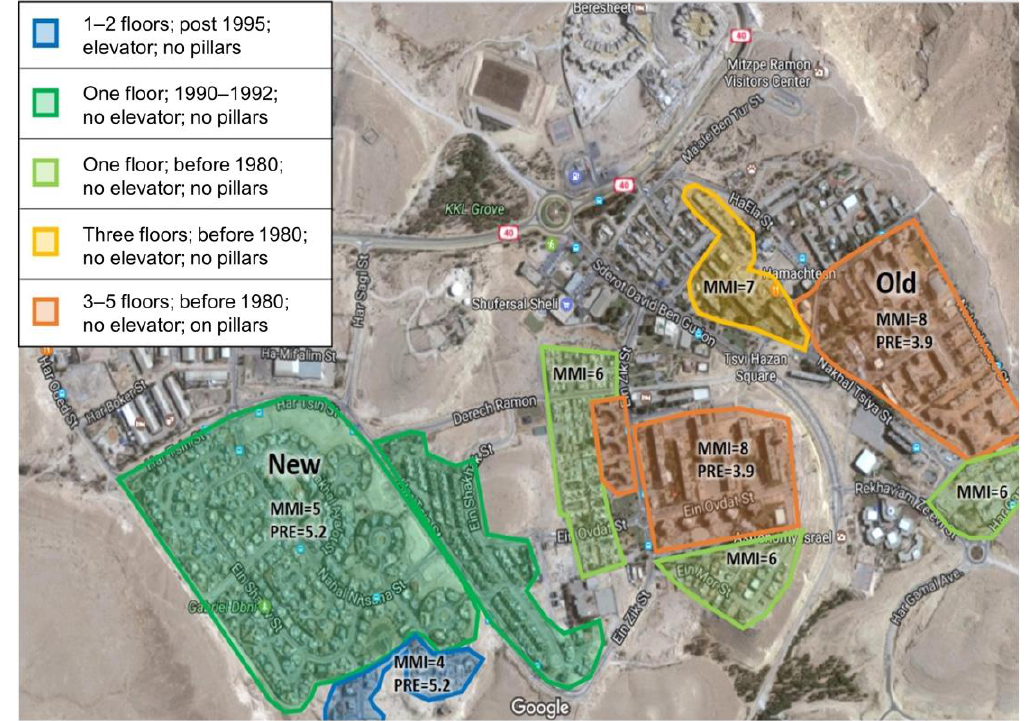
Figure 3. Intensity (MMI) and preparedness (PRE) of neighborhoods in Mitzpe Ramon (polygons, color coded based on MMI data, average PRE stated where sufficient data exists). PRE scores were calculated separately for the two new neighborhoods (PRE = 5.2) and for the two largest old neighborhoods (PRE = 3.9).